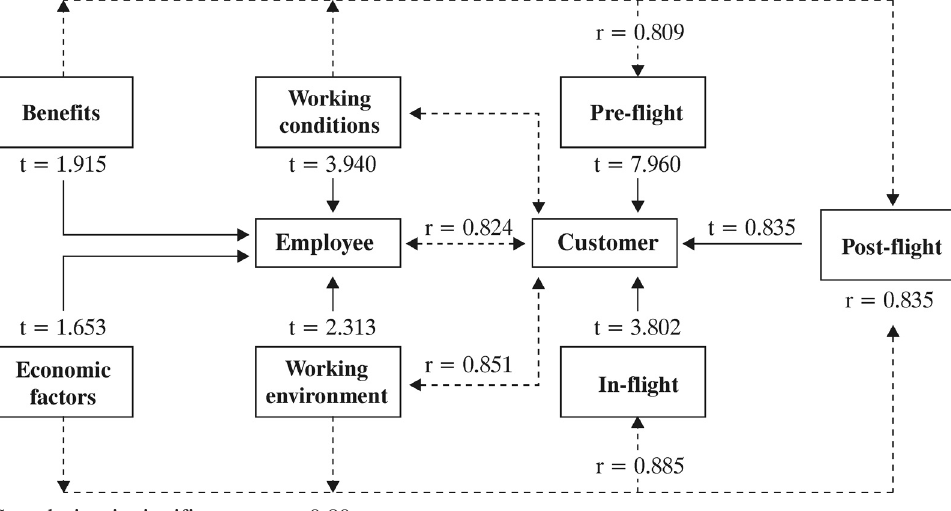
Correlation is significant at r >